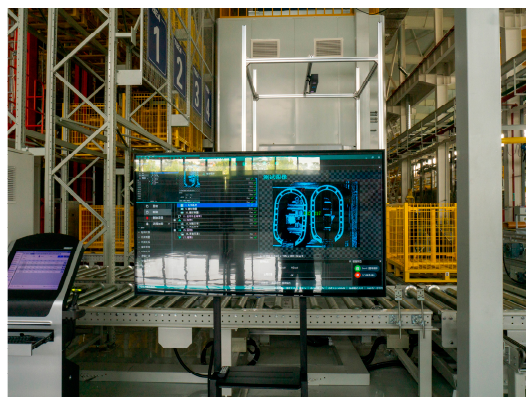
Figure 7. Machine vision quality inspection.